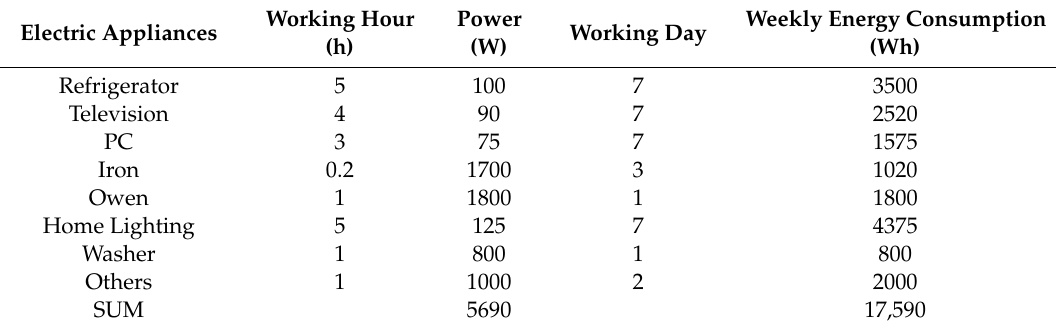
Table 1. Average electric consumption of a